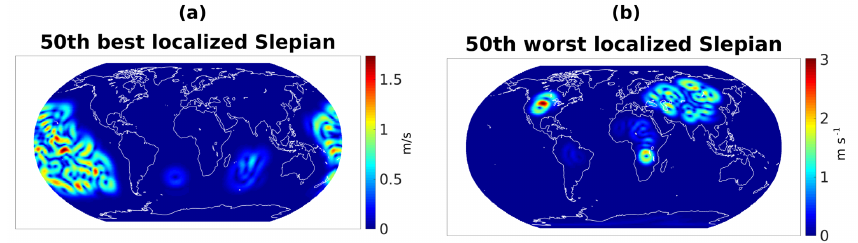
= 0 . 91 (a) and a = 0 . 67 (b) . The fixed nodal point η r r